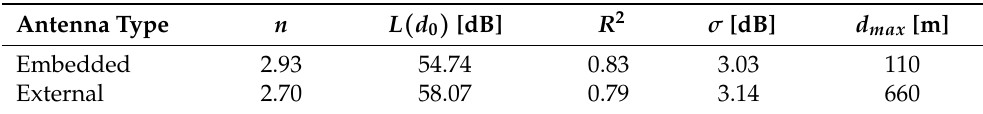
Table 10. Path loss regression coefficients and statistical results for Non-Line-of-Sight scenario (one turn).